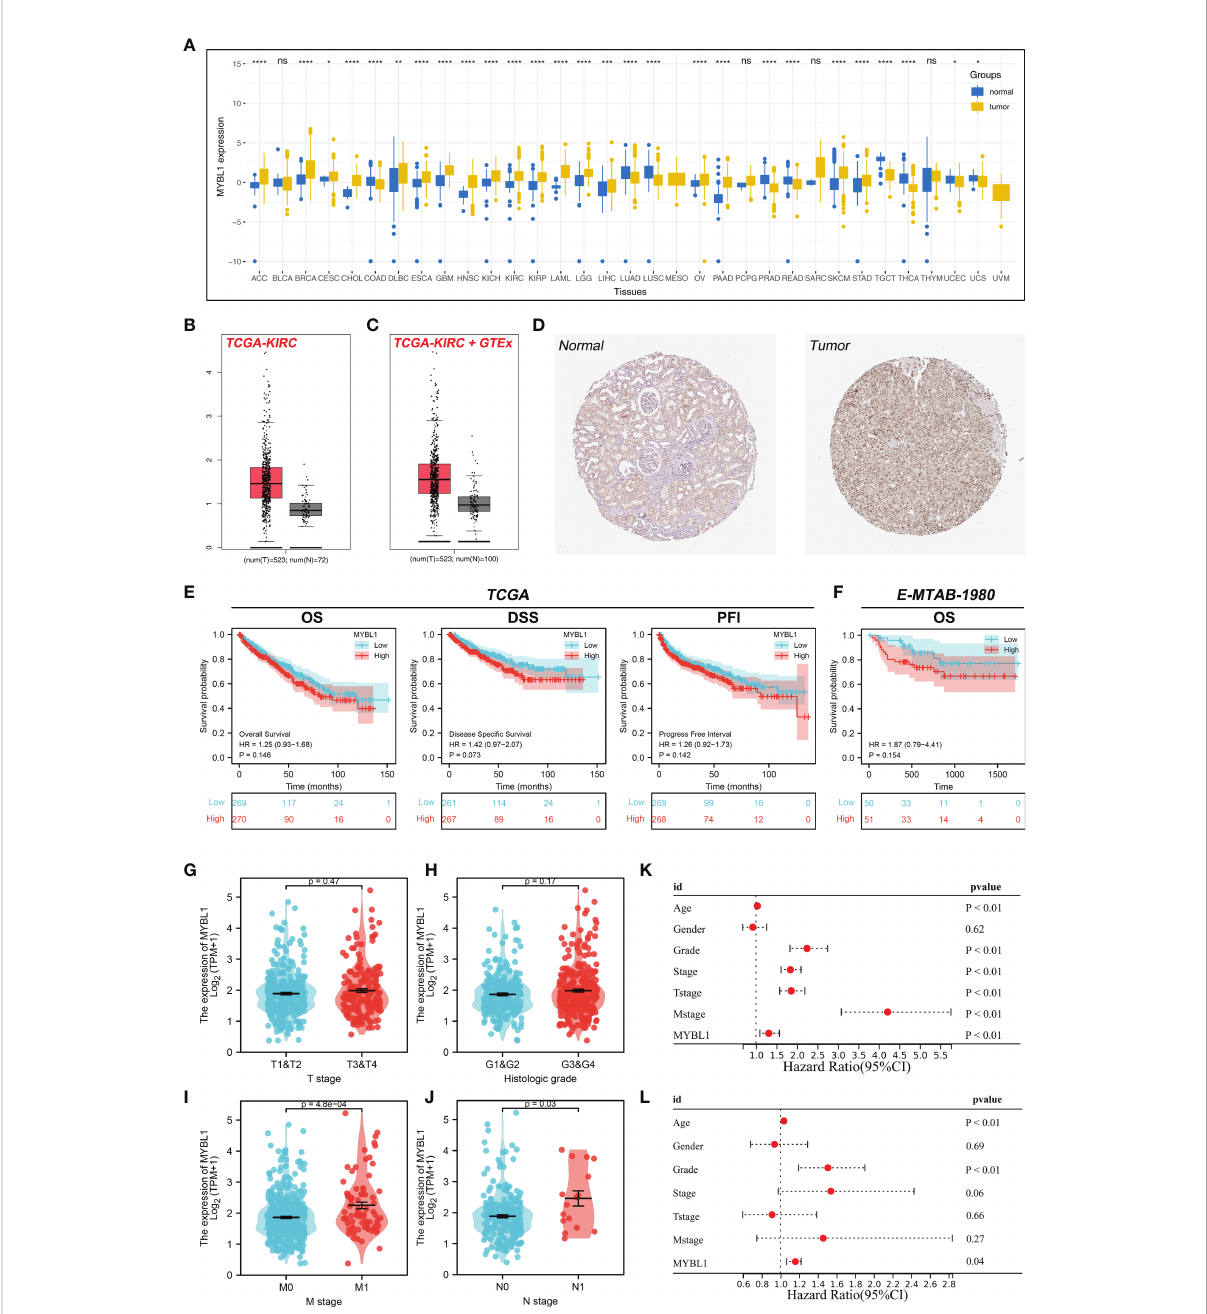
FIGURE 1 Expression pattern and clinical role of MYBL in ccRCC. (A) The landscape of MYBL1 in pan-cancer; (B) Expression of MYBL1 in ccRCC tumor and normal tissue based on the TCGA database; (C) Expression of MYBL1 in ccRCC tumor and normal tissue based on the TCGA+GTEx database; (D) Representative immunohistochemical images of MYBL1 in HPA database; (E) Prognosis performance of MYBL1 in TCGA database; (F) Prognosis performance of MYBL1 in E-MTAB-1980 database; (G-J) Clinical correlation of MYBL1; (K, L) Univariate and multivariate analysis of MYBL1. *P < 0.05, **P < 0.01, ***P <0.001, ****P <0.0001, "ns" means P >